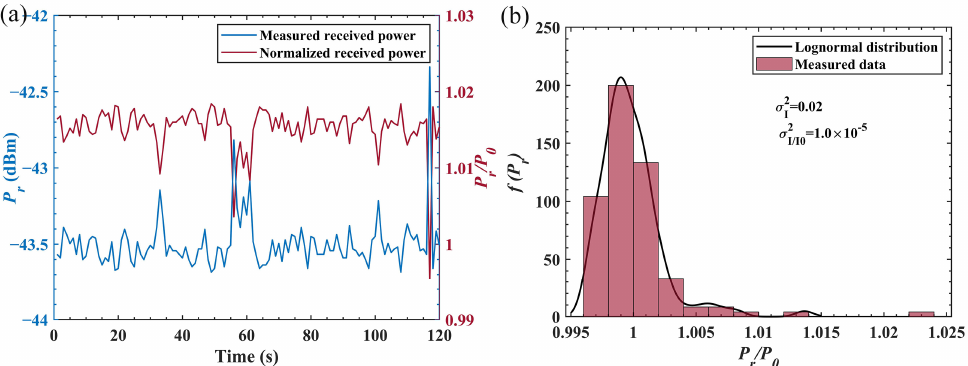
Figure 7. The test results of turbulence: ( a ) the measured and normalized power variation as a function of time, ( b ) the histogram of the measured data with the PDF of normalized power and scintillation.